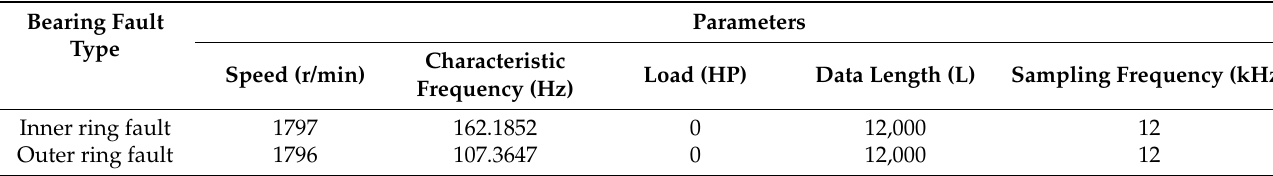
Figure 14. Apparatus & procedures: ( a ) Experimental platform. ( b ) Skf6205 deep groove ball bearing.